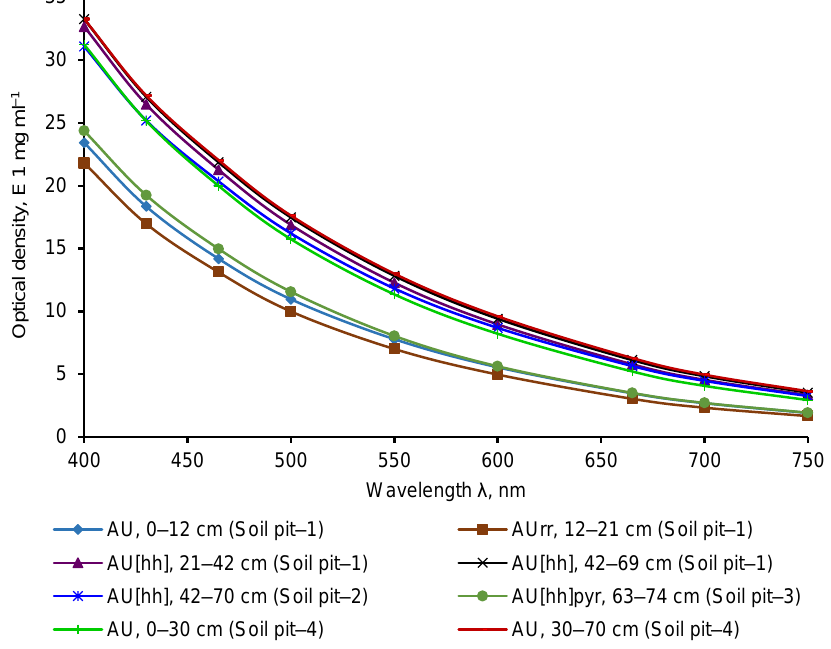
Figure 6. Curves of optical density of HA2 fraction at different wavelengths.